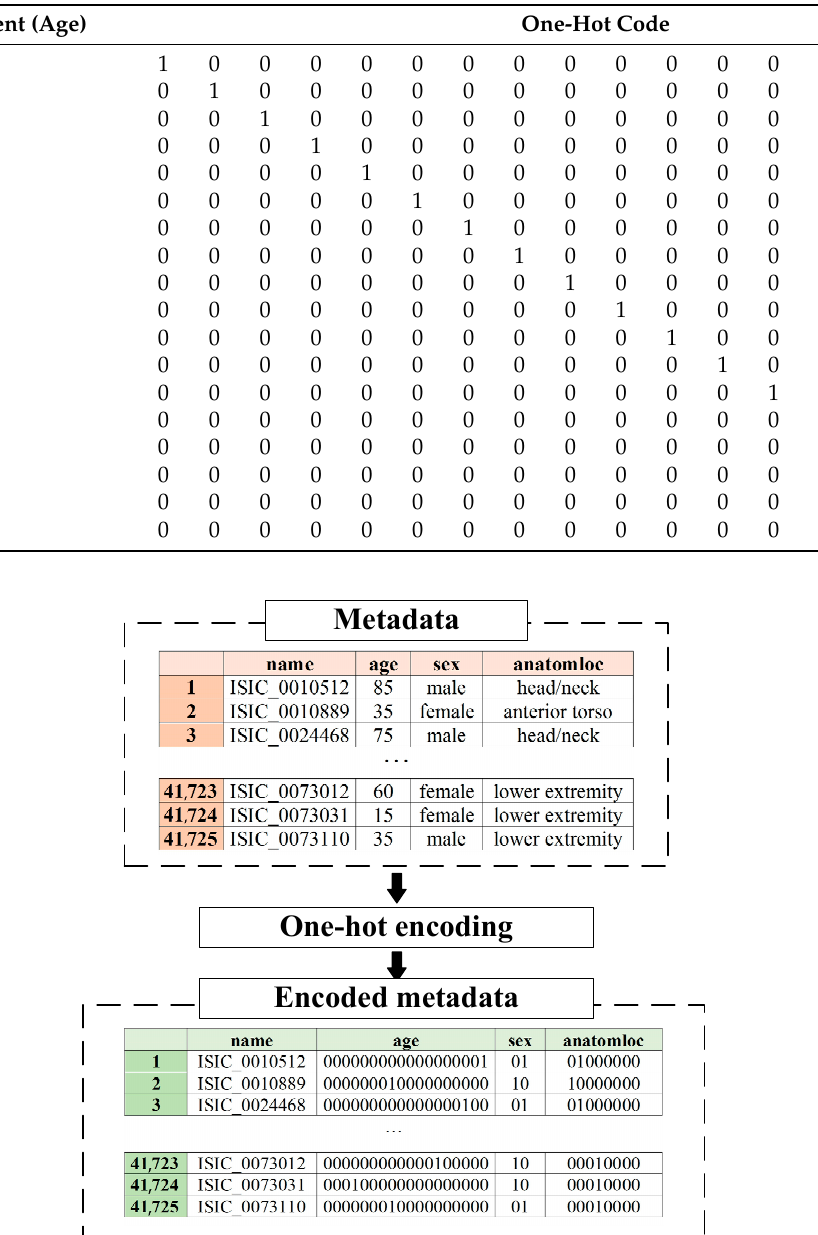
Table 3. A coding table for patient age metadata.